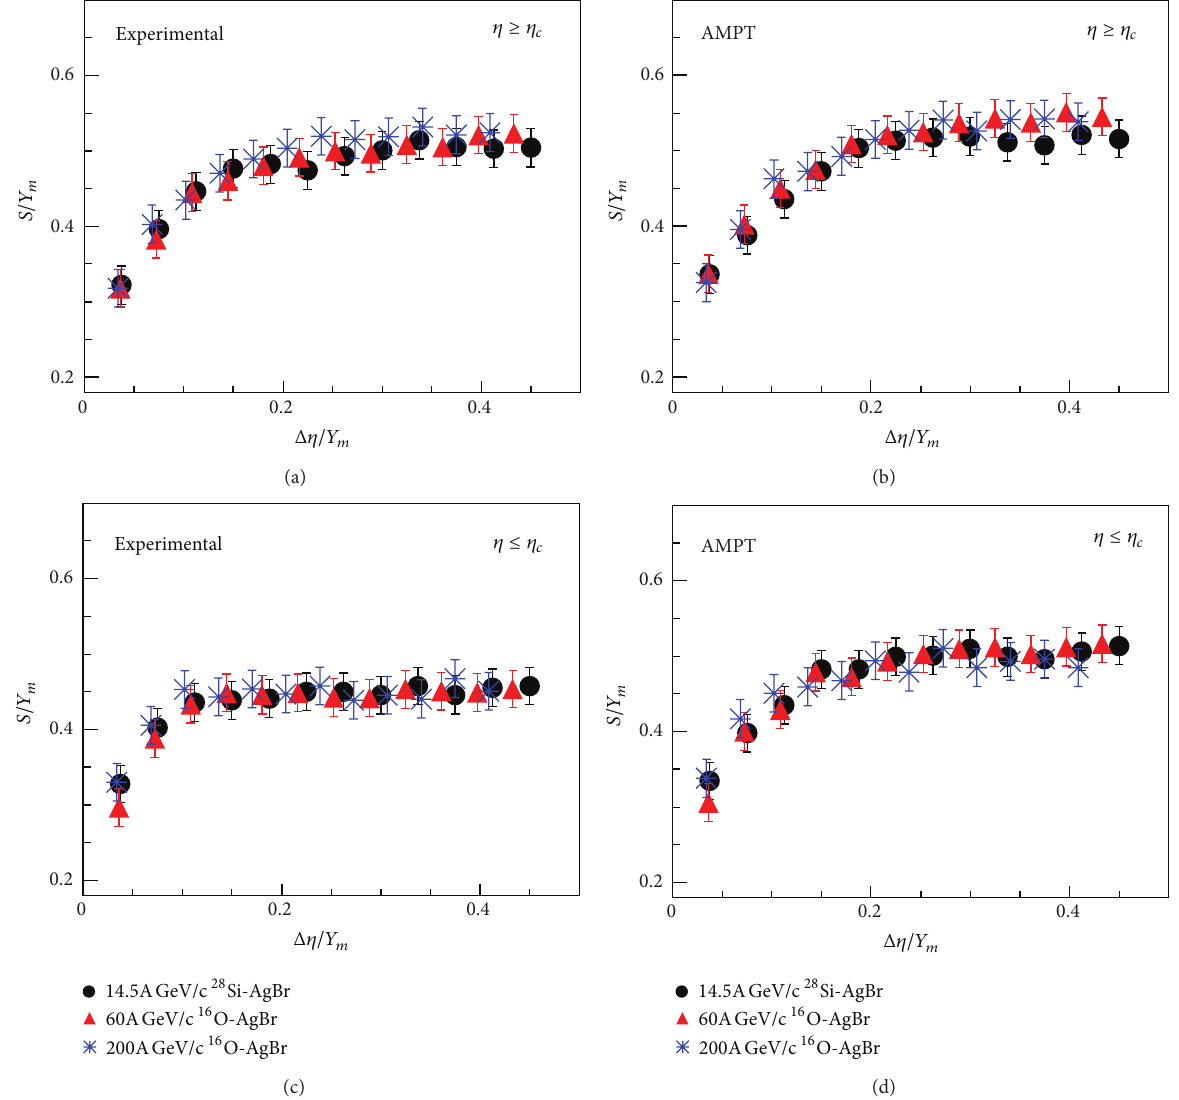
Figure 6: Dependence 𝑆/𝑌 𝑚 on Δ𝜂/𝑌 𝑚 in the forward and backward regions for the real and AMPT events at the three incident energies.